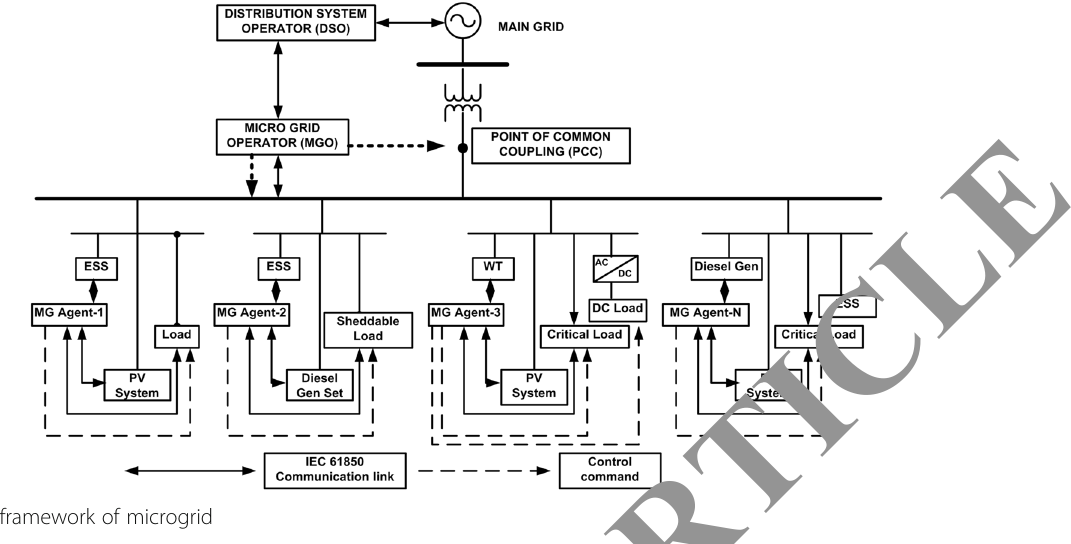
Fig. 2 Typical framework of